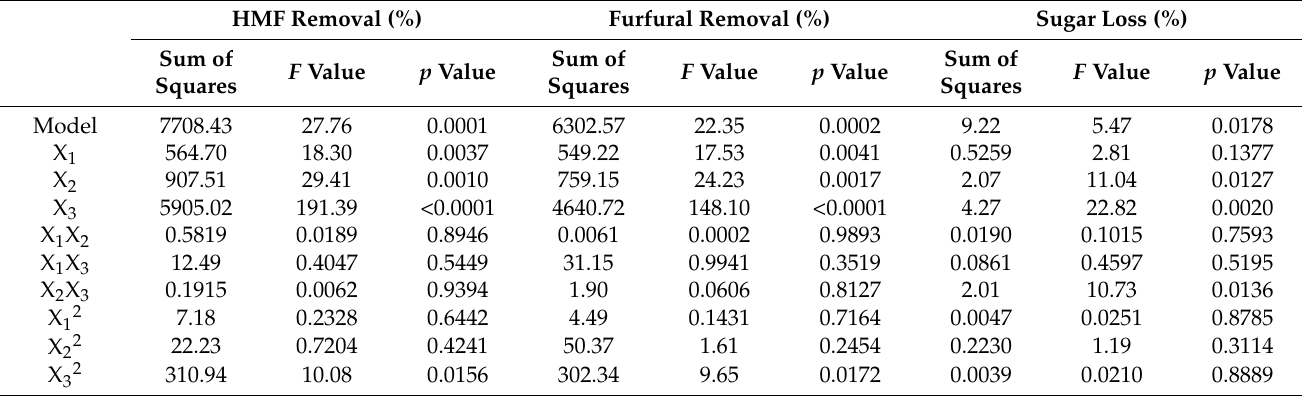
Table 5. Analysis of variance of the experimental results of central composite design for second-order polynomial models. HMF Removal (%)